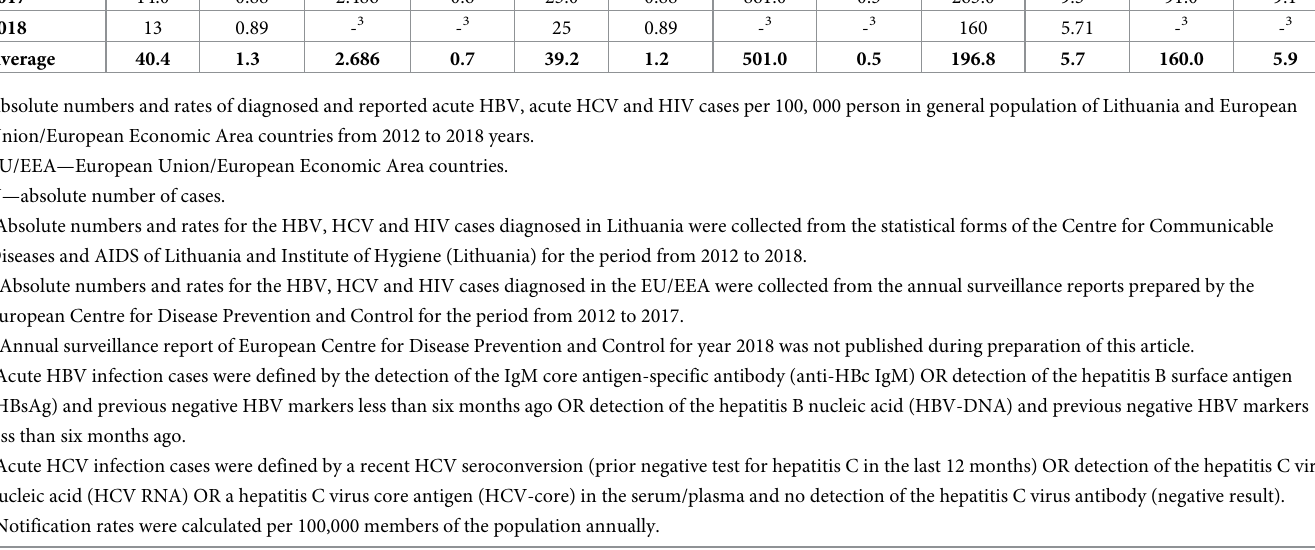
EU/EEA—European Union/European Economic Area countries. N—absolute number of cases.